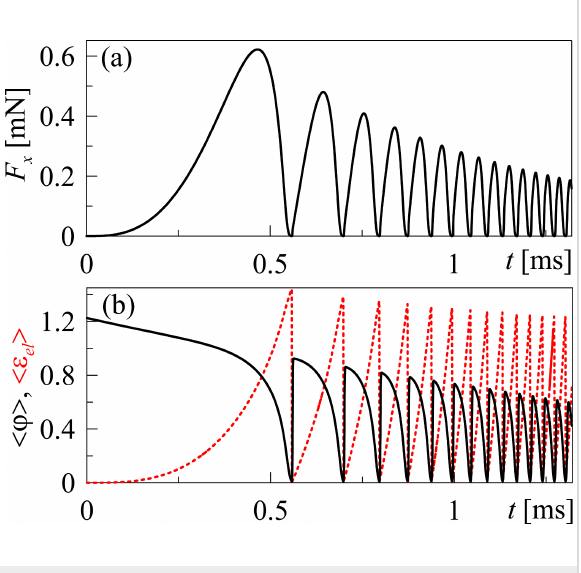
Figure 4: (a) Time dependence of the friction force F x (Equation 16) using the parameters of Figure 2 and an increasing temperature ac- cording to Equation 18 using the parameters A 0 = 1.5·10 6 Pa and s. (b) Mean values of the order parameter < φ > and elastic strain < ε el > are according to the parameters of Figure 4a.